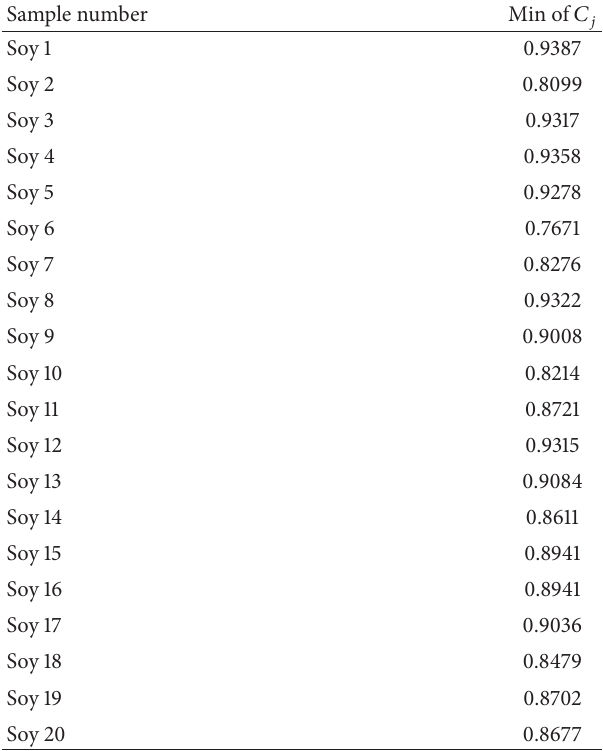
Table 2: The minimum 𝐶 𝑗 of 20 soybean meal samples calculated by